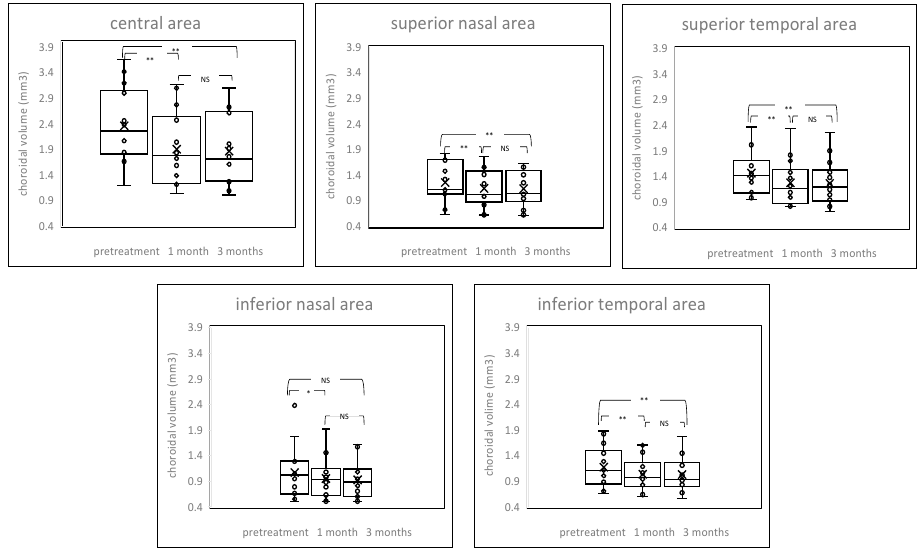
Figure 1. Box-plot graphs of choroidal volume before and after treatment. The post treatment choroidal volume showed a significant reduction from baseline at all time points after the PDT, including both irradiated central area and non-irradiated peripheral areas. NS = not significant, * p < 0.05, ** p < 0.01.